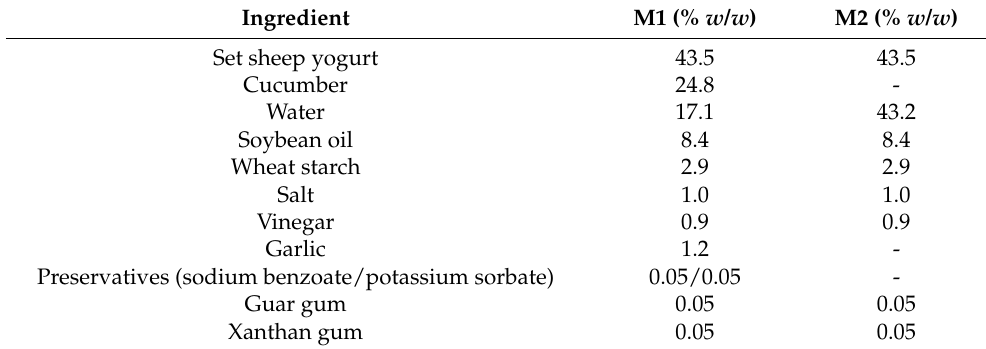
Table 2. Proportions used for the preparation of samples M1 and